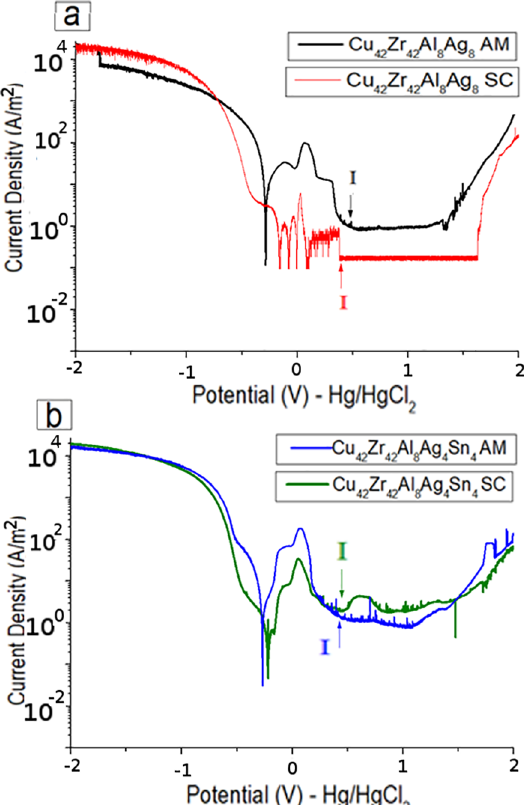
Figure 6. Potentiodynamic polarization curves for arc-melted (AM) and suction-casted (SC) samples. The selected points for passivation current density (I) acquisition are indicated by arrows. Table 3. Obtained passivation currents for arc-melted (AM) and suction-casted (SC) samples.